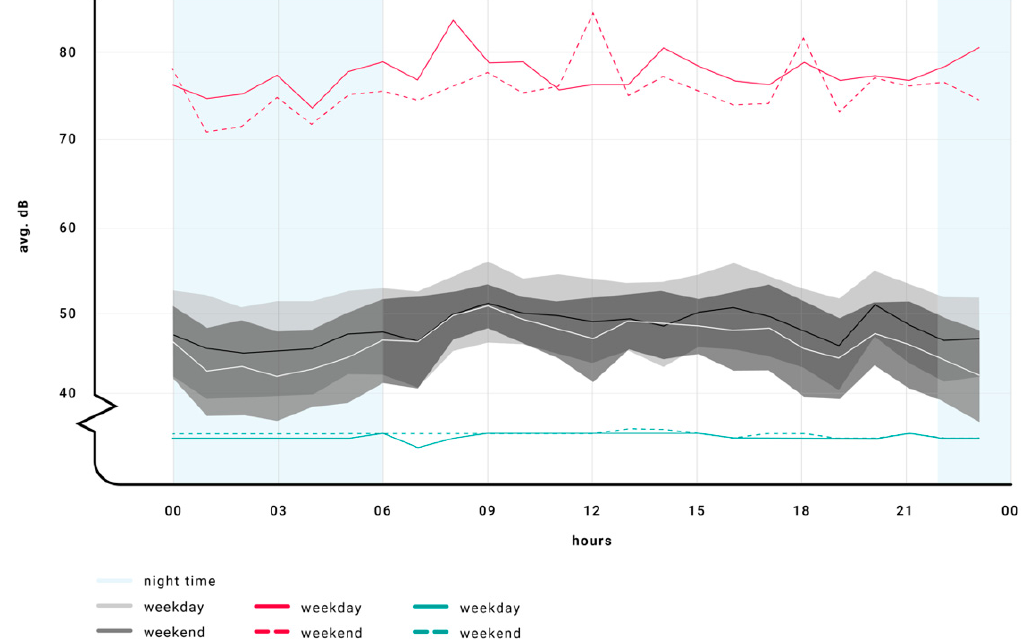
Figure 1. Average sound recordings over the week in an IC patient room at the Erasmus Medical Centre, Rotterdam. The Sound Pressure Level was measured each second over the course of 24 h and then averaged for weekdays and weekends. The data illustrate that the WHO guidelines are regularly exceeded over the course of the day. Note that these data were measured in the previous IC department of Erasmus MC. Since mid-2018, the department has moved to a newly build IC department, where management of the soundscape has been given more attention. The data were acquired by the authors through the use of Quietyme Inc.